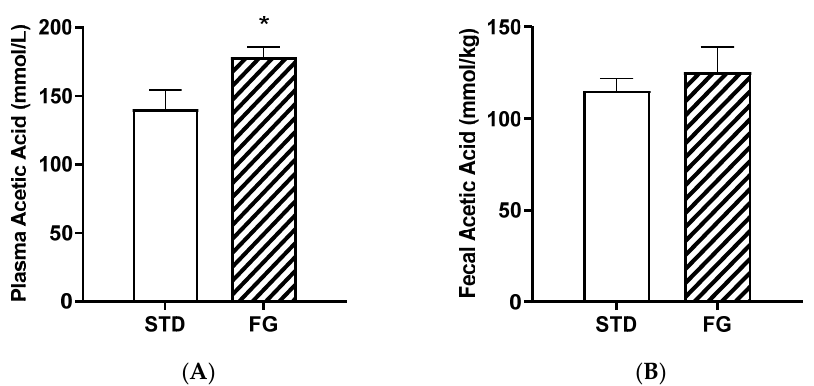
Figure 4. Acetic acid concentrations in plasma ( A ) and feces ( B ) from rats ( n = 8–9) supplemented or not with D ‐ fagomine for 6 months. Comparisons were conducted using Student’s t ‐ test. * p < 0.05.